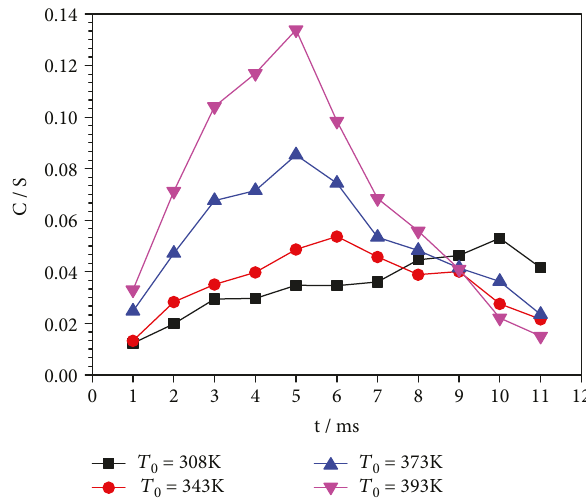
Figure 8: Perimeter-to-area ratio at fl ame development